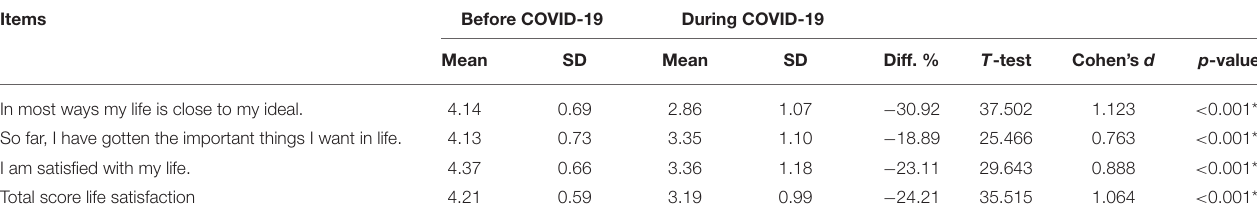
TABLE 4 | Responses to the Short Life Satisfaction Questionnaire-Lockdowns (SLSQL) before and during the COVID-19 pandemic ( n = 1,115). Items Before COVID-19 During COVID-19 Mean SD Mean SD Diff. % T -test Cohen’s d p -value In most ways my life is close to my